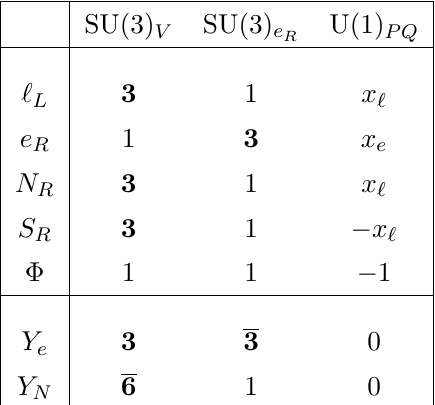
Table 5 . Transformation properties of the SM leptons, exotic neutral leptons and spurions under the global symmetries G SU(3) V F